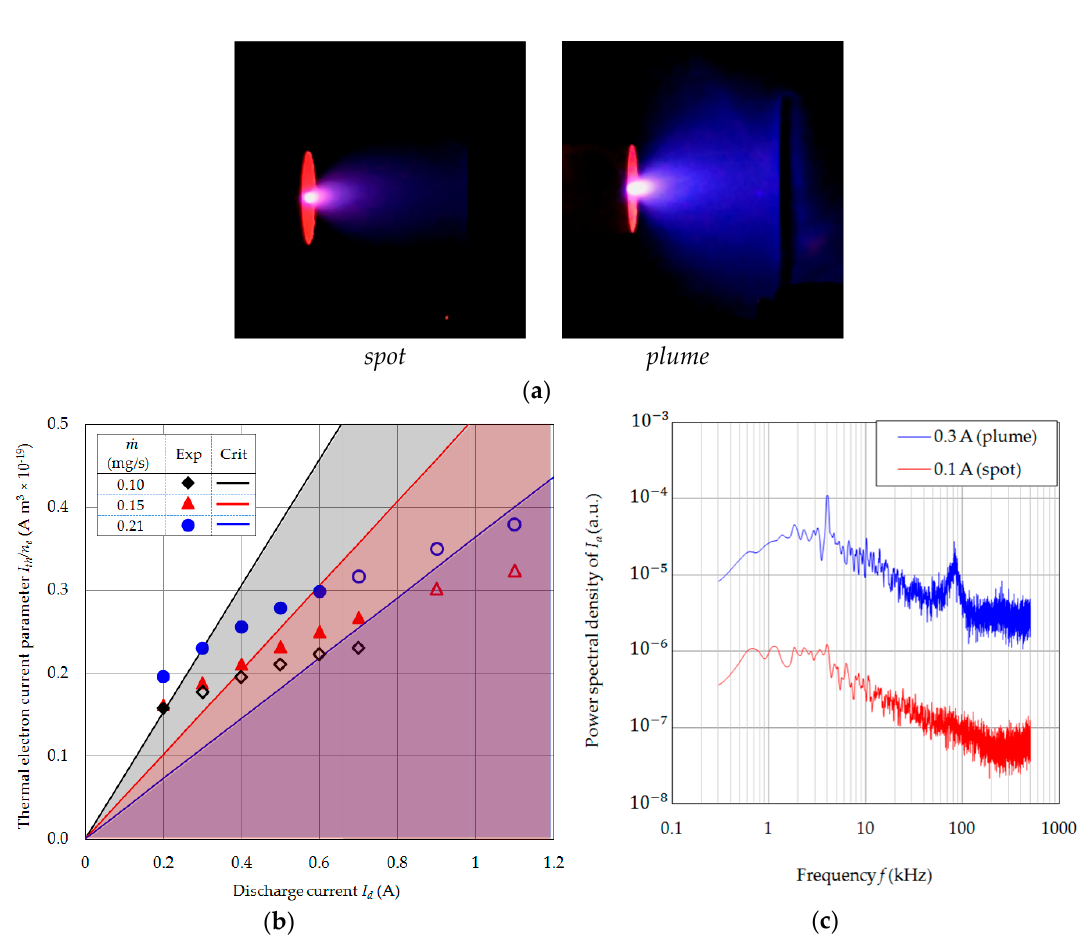
Figure 12. Cathode discharge modes: ( a ) cathode plasma discharge in spot and plume mode; ( b ) example of cathode discharge mode identification utilizing different criteria—closed and open symbols stand for discharge in spot and plume modes, respectively, based on the anode current oscillation criterion [58,59], while the thermal electron current parameter, I th / n e , is presented against the discharge current, I d . The shaded regions define the plume mode operation based on the criterion of Georgin et al. [60]; ( c ) example of power spectral density of the cathode discharge current for spot and plume modes. Cathode discharge is in a triode mode with 0.1 A of keeper current. Reprinted from Potrivitu et al., Journal of Applied Physics 127, 064501 (2020) [30], with the permission of AIP Publishing.